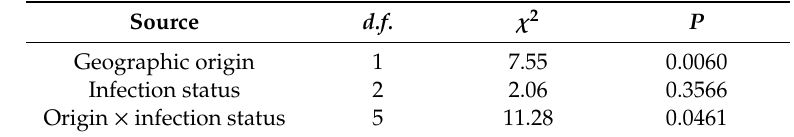
Table 3. PROC LIFETEST results of geographic origin, infection status, and interaction on adult survival of populations of Aedes aegypti from Brazil and Florida following oral exposure to Mayaro virus.